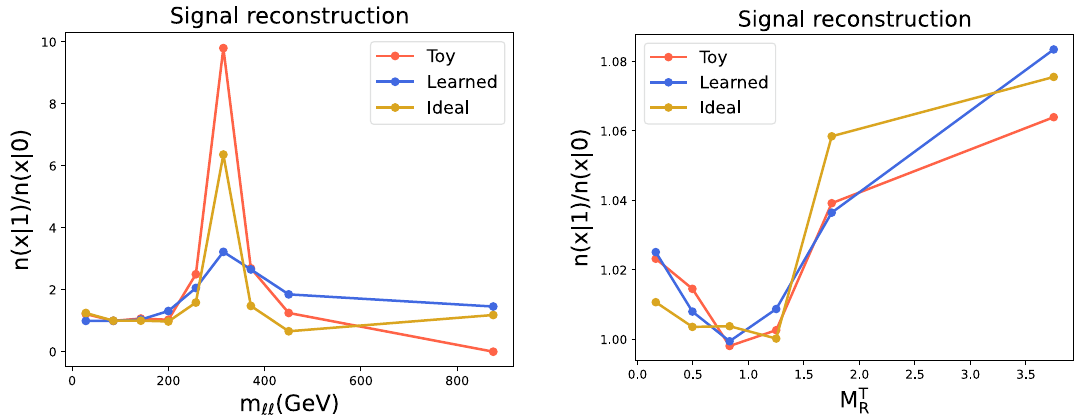
Fig. 6 Examples of reconstructed density ratios as a functions of high-level features (not given as inputs) for the DIMUON (left) and SUSY (right) datasets with new physics components in the data. Note that the SUSY dataset is normalized